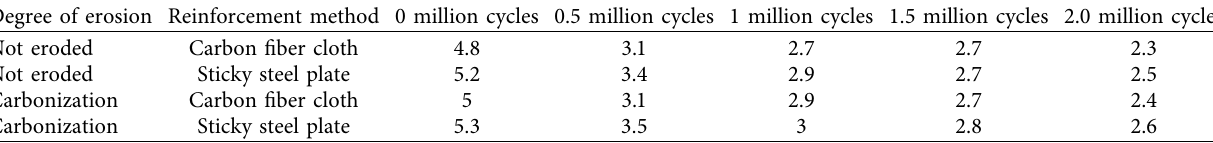
Table 17: Trend of modal of test plates under different fatigue cycles.